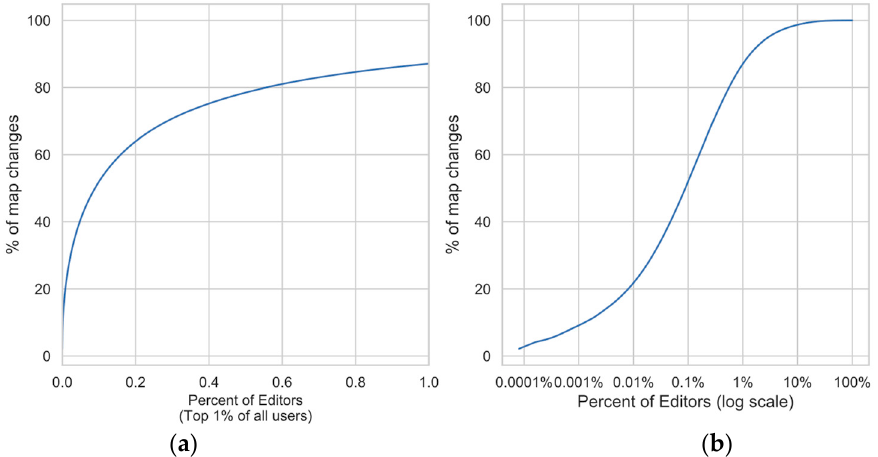
Figure 2. ( a ) The top 1% of users are responsible for 87% of all the changes to the map; ( b ) OSM adheres to the 1% rule: a very small percentage of the editing community contributes the majority of the data. Results calculated from the OSM changeset database described in Figure 1.